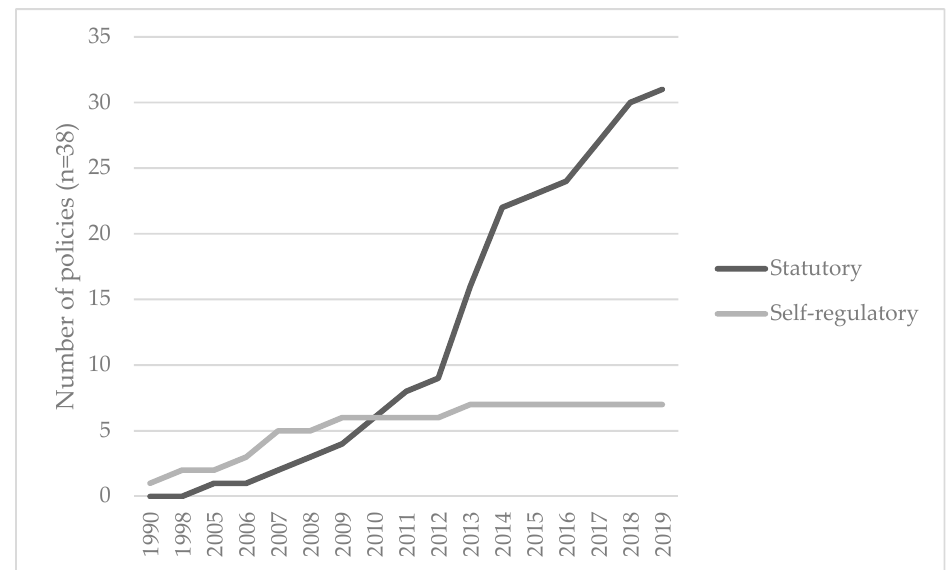
Figure 2. Type of implemented policies that restrict the marketing of food and beverage products in 14 countries from the WHO Americas Region *, 1990–2019. * Data show policy characteristics from a purposive sample of 14 countries of the World Health Organization (WHO) Americas Region, namely, Argentina, Bolivia, Brazil, Canada, Chile, Colombia, Costa Rica, Dominican Republic, Ecuador, El Salvador, Mexico, Peru, Uruguay, and USA. Table 3. Policies to restrict the marketing of HFSS ** food and beverage products to children in 14 countries of the WHO Americas Region *, 1990–2019.